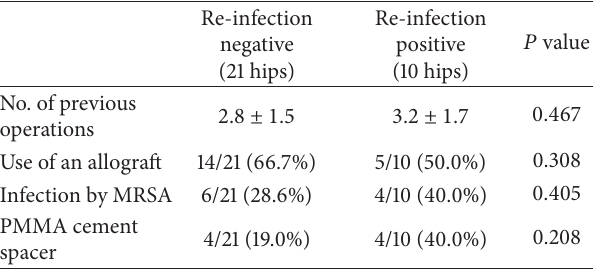
Table 2: Comparison of the possible prognostic factors of re-infection between the re-infection-positive and re-infection- negative groups after the second-stage revision surgery in 31